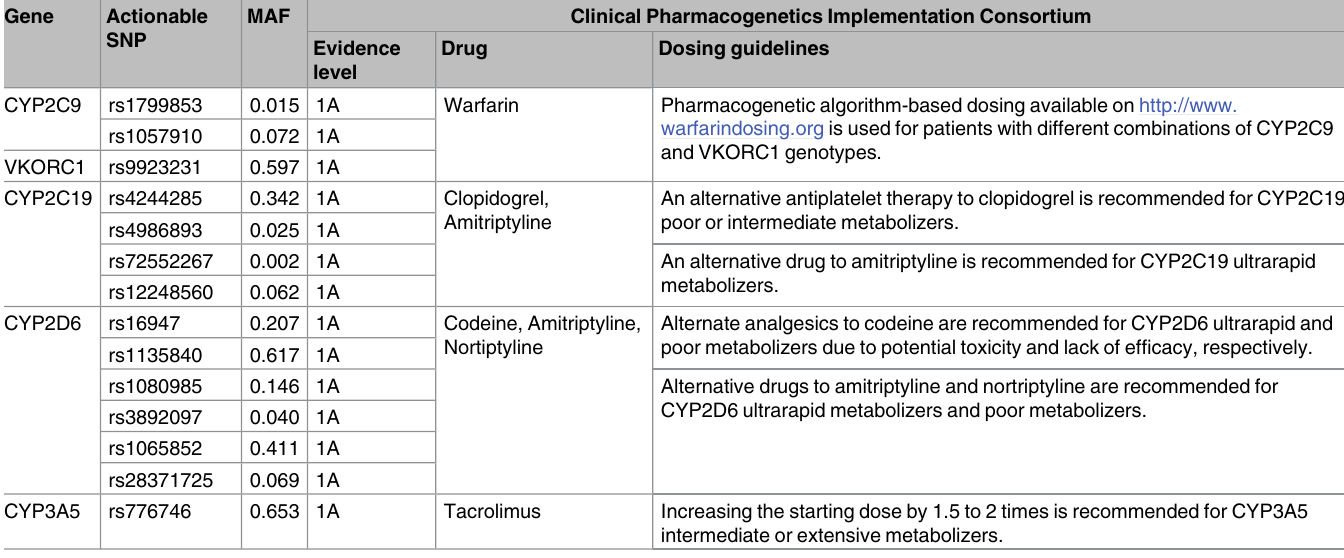
Table 6. Recommendations for actionable pharmacogenomic markers based on CPIC